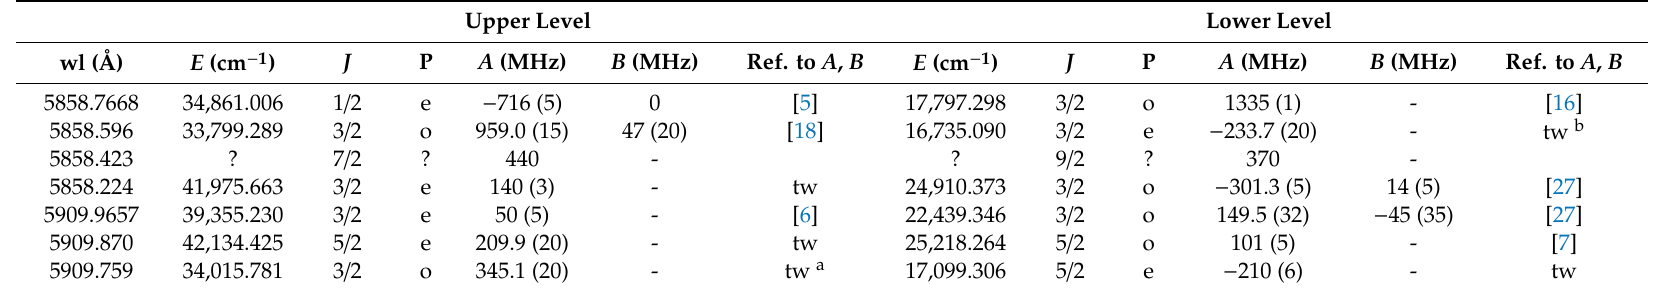
Table 2. Classification of the lines shown in Figures 1 and 2. wl—wavelength; E —energy. The hf pattern of the line at 5858.423 Å could be simulated well using the J - and A -values given in the table, but could not be classified